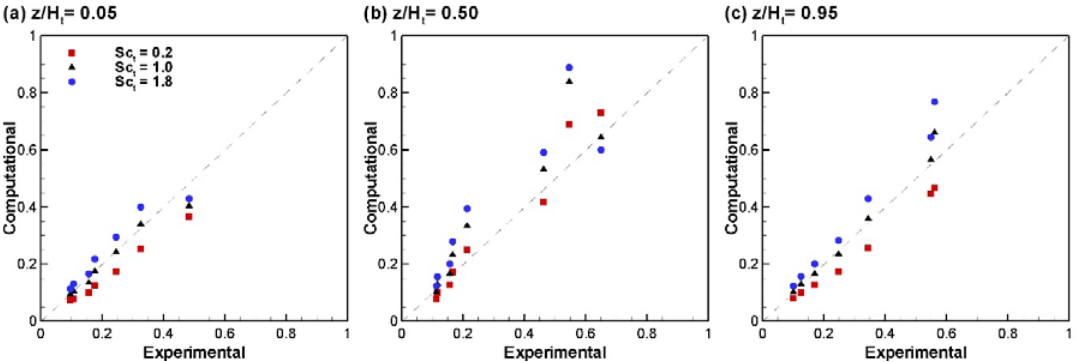
Figure 4. Dispersion index values predicted numerically and experimentally for the contact tank tracer sampling points at ( a ) z/H t = 0.05 in; ( b ) z/H t = 0.5; ( c ) z/H t = 0.95.